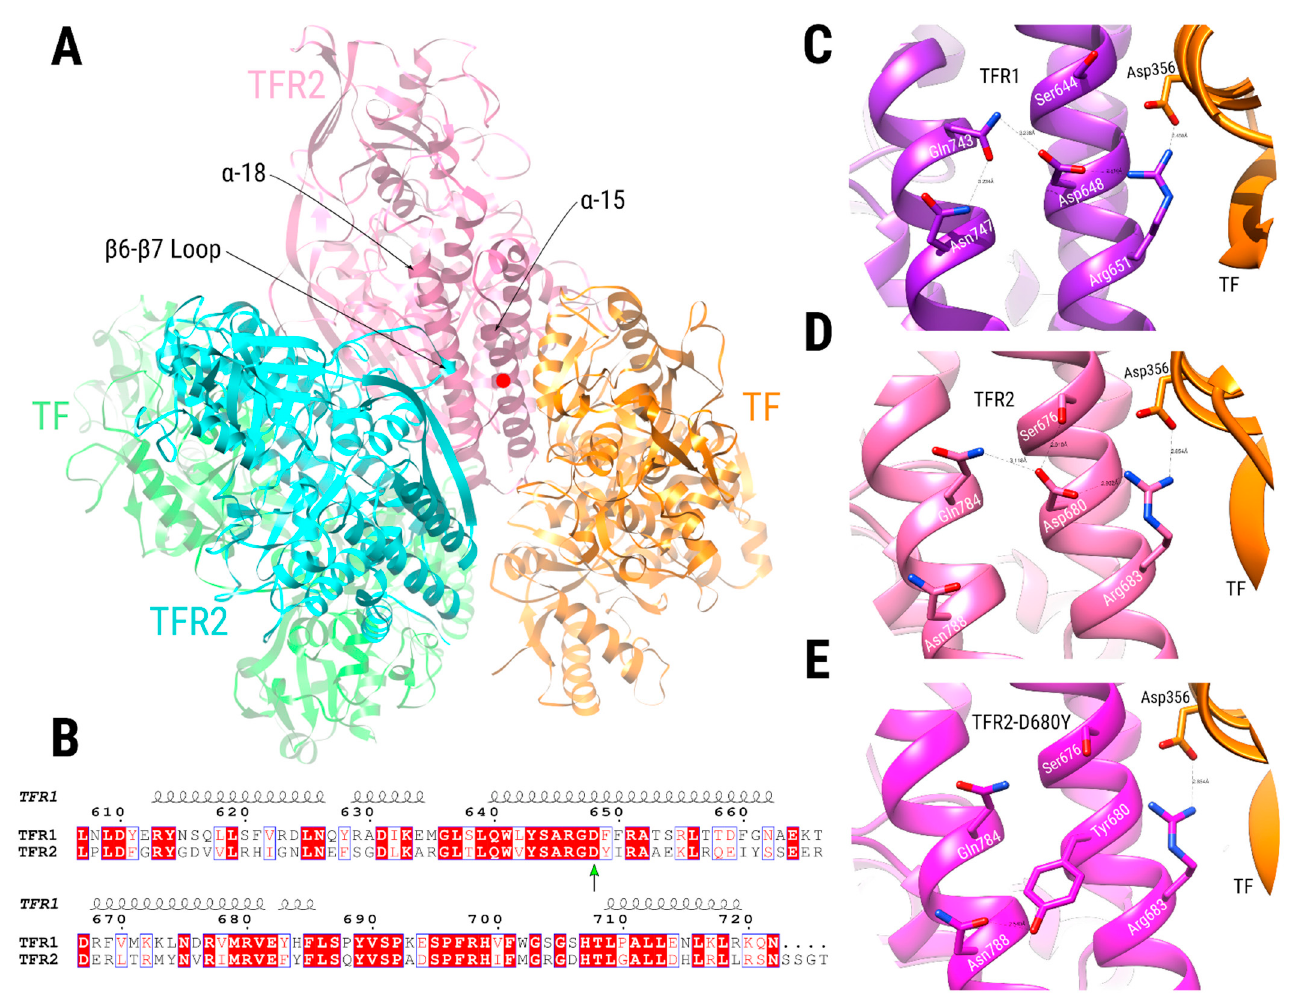
Figure 5. Comparative modeling of the TFR2 dimer complexed with TF. ( A ) TFR2 chains are shown in cyan and pink, while TF chains are shown in green and orange. Dimeric interactions between TFR2 chains, close to Asp680 position (red circle at the α -15 helix, pink chain), are made between residues in the α -18 helix of one TFR2 chain (pink chain) and the loop located between the β -6 and β -7 strands of the other (cyan chain). ( B ) Sequence alignment of the TFR1 and TFR2 proteins near the TFR2 680 position (green arrow). Numbering is according to the TFR1 sequence, and the secondary structure depiction is based on the TFR1 structure (PDB ID 1CX8). The alignment coloring was produced by the ESPript 3.0 web server [40], where position with red background means absolute sequence conservation. ( C – E ) Structural context of positions TFR1-Asp648 ( C , purple), TFR2-Asp680 ( D , pink), and TFR2-Asp680Tyr ( E , magenta). Residue names of TFR1/2 appear in white, while residues in TF are in black. Significant interactions are shown with dashed lines.